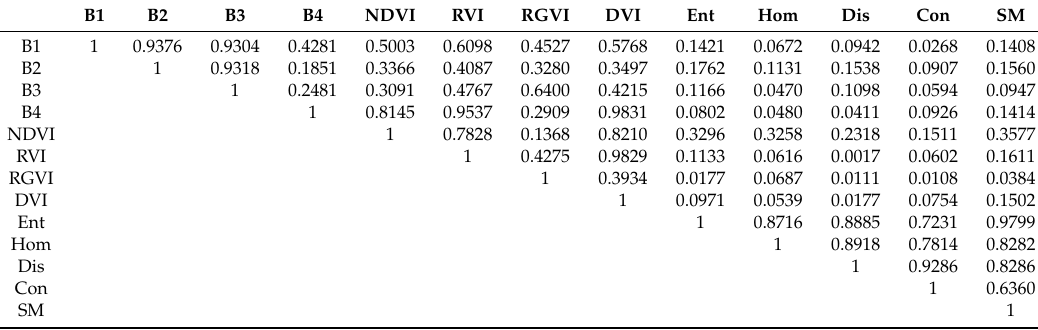
Table 1. The Pearson product moment correlation coefficients among 13 spectral variables (note: all coefficients were absolute